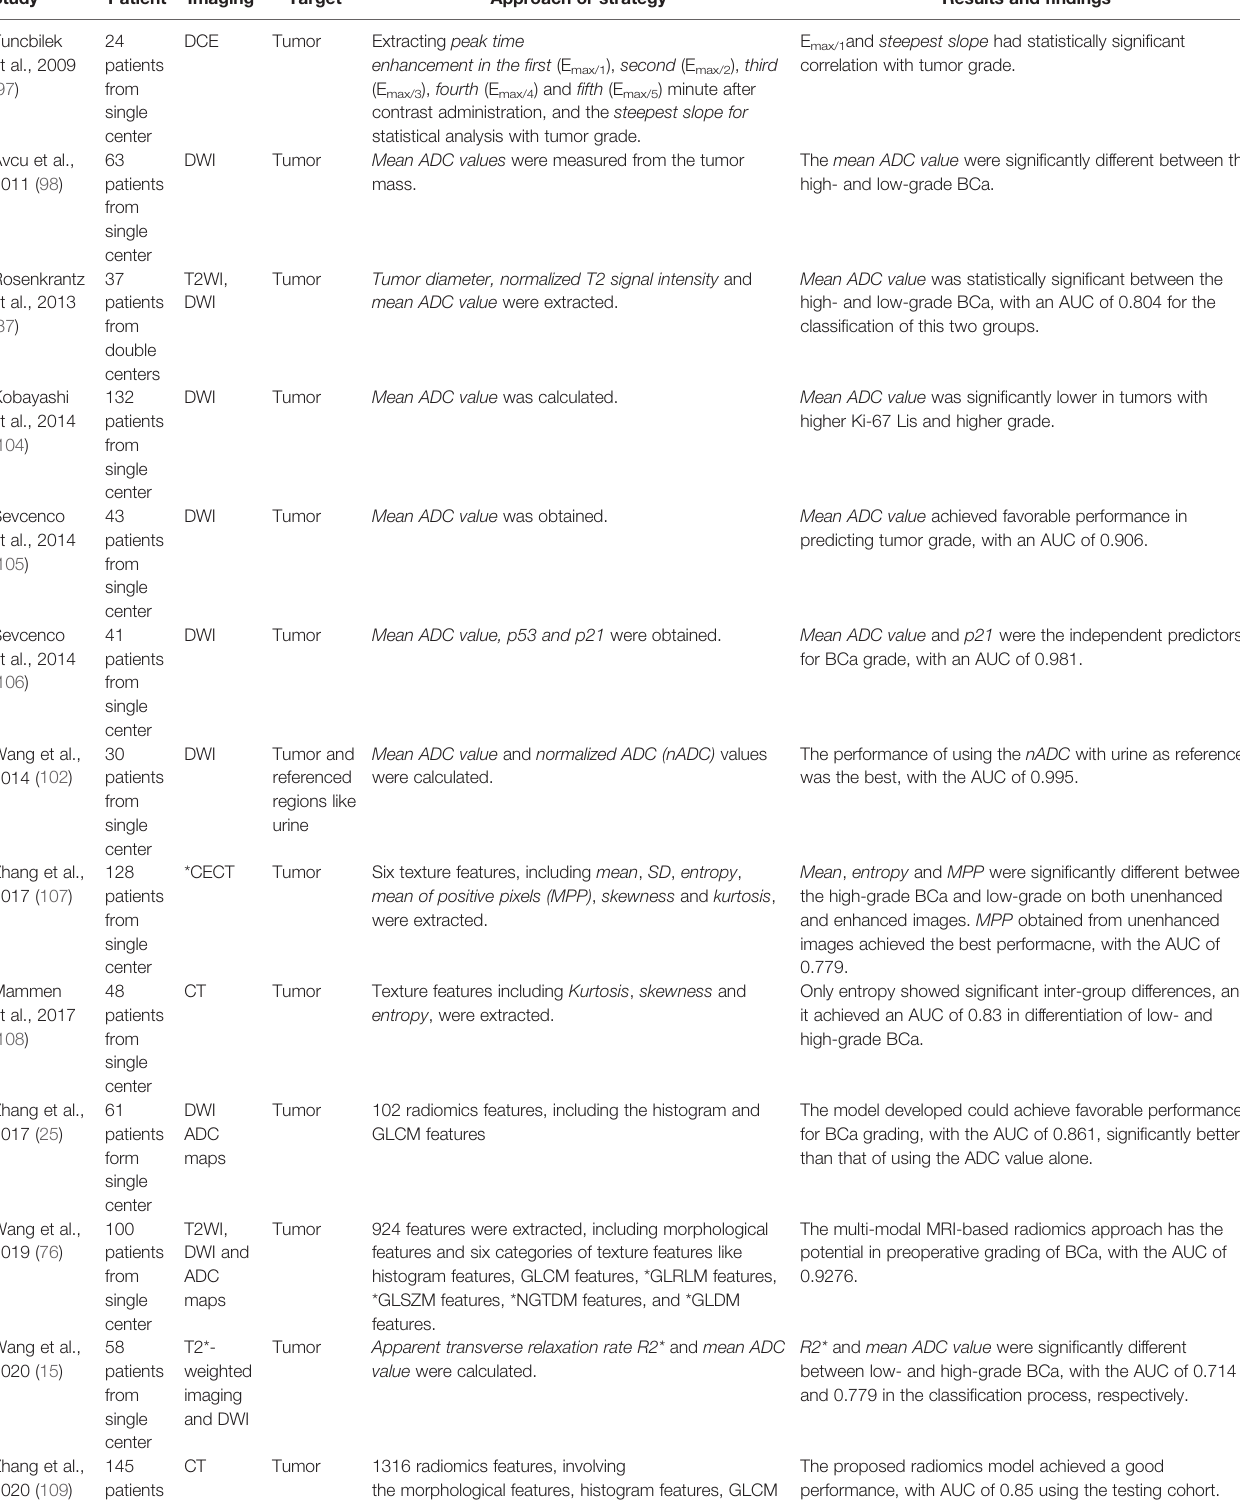
TABLE 2 | Related studies and strategies of CT-/MRI-based BCa grading during the past 20 years. Study Patient